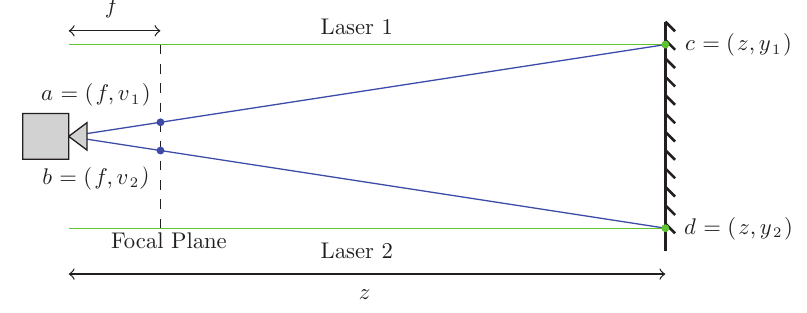
Figure 6. Side view of the sensor.